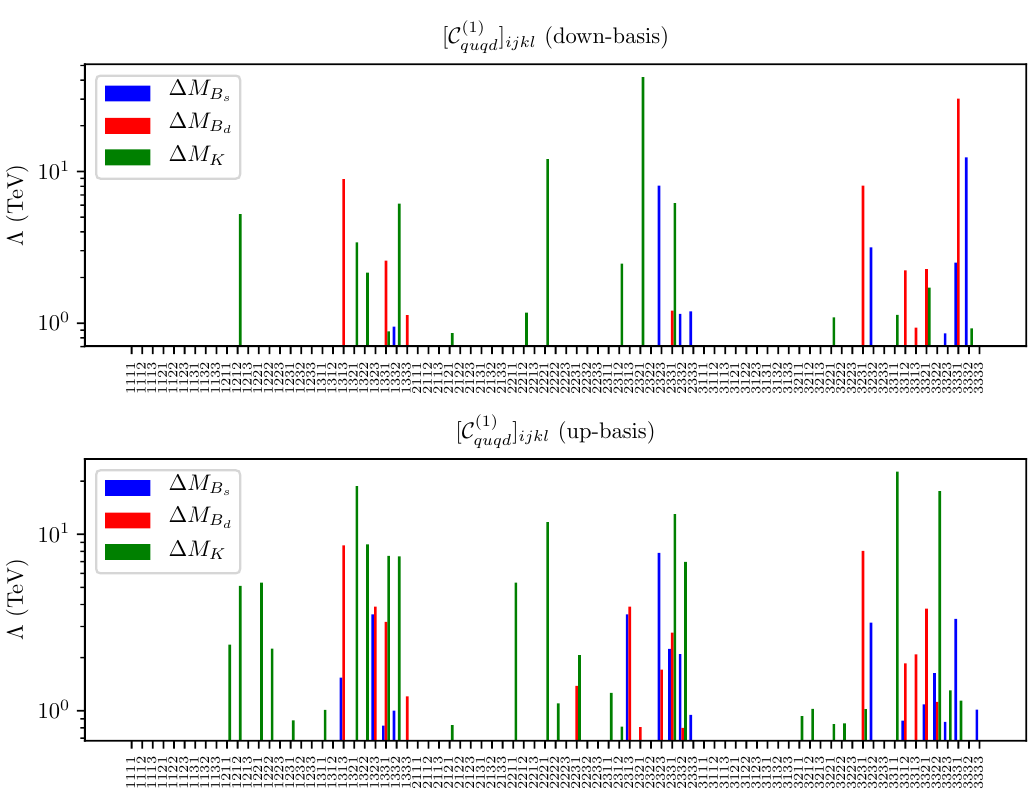
(cid:2) (cid:3) c (1) = 10 that corresponds to a 10% effect in quqd ijkl